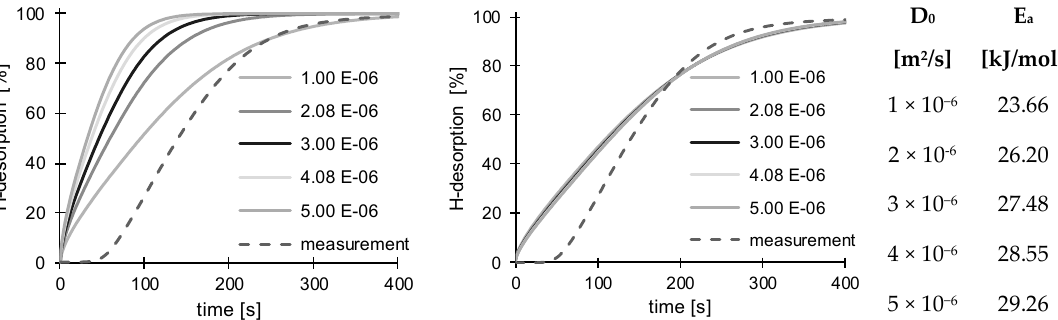
Figure 20. Calculated desorption curves at the beginning ( left ) and after completion of the iteration ( right ) by means of an isothermal 200 °C—measurement.